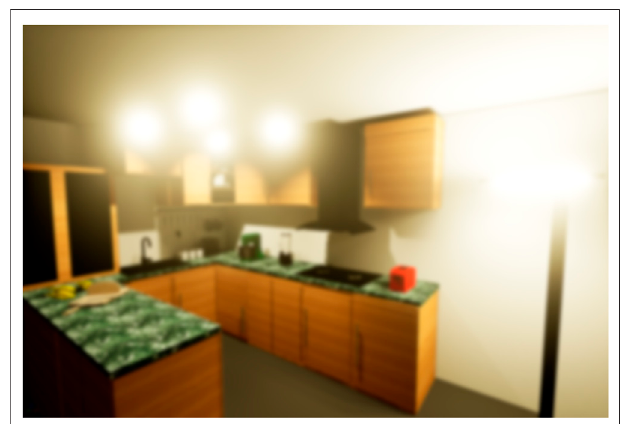
FIGURE 4 | ICthroughVR simulates the effects of cataracts in VR. Image courtesy of Krösl et al.